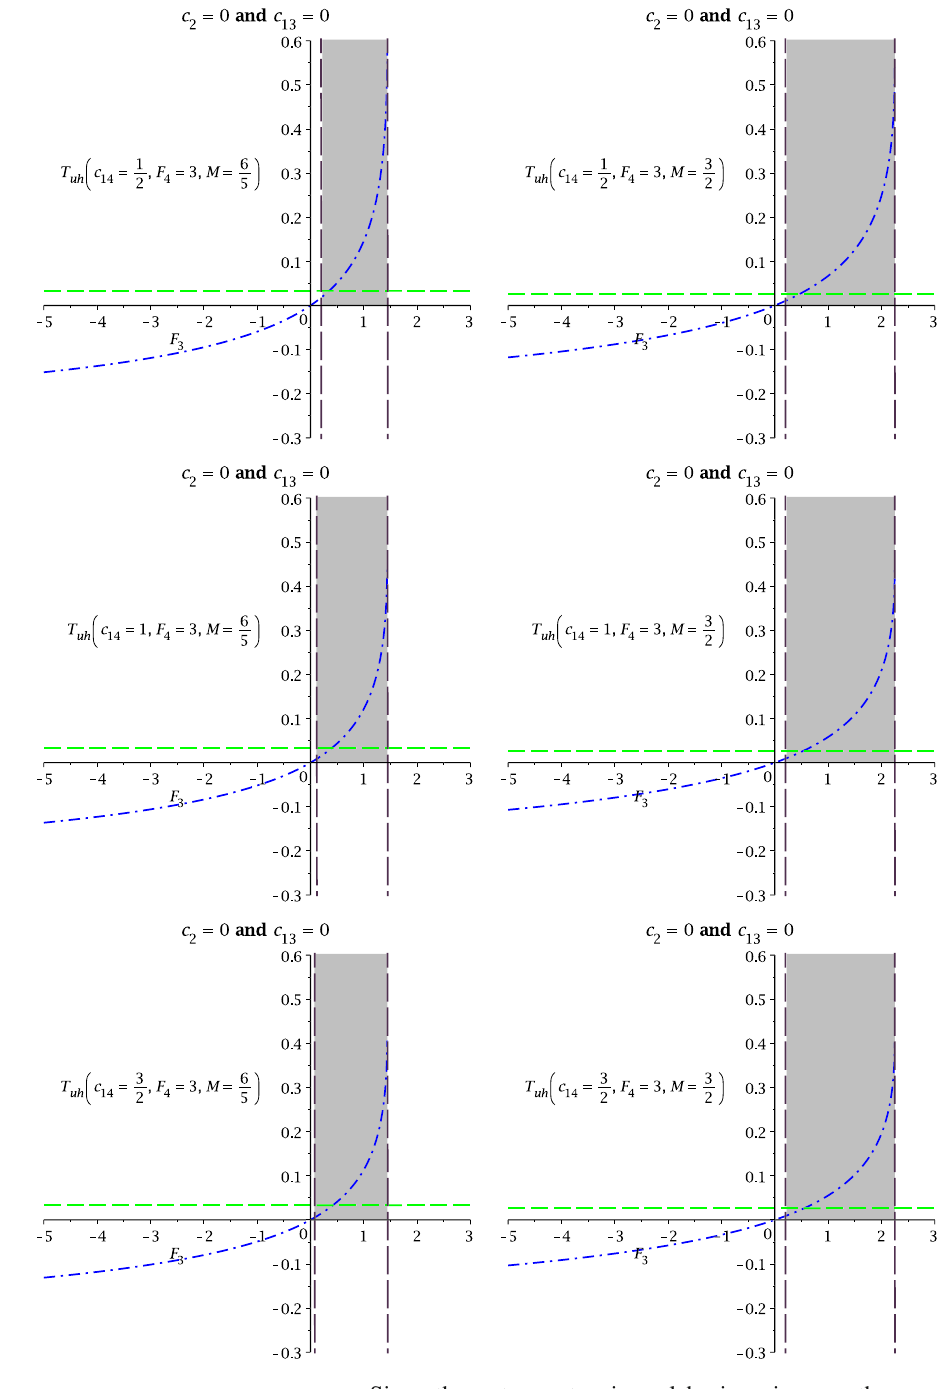
Fig. 5 These figures show the universal horizon temperatures, for the Case D, where we have: T uh 1 (blue dot-dashed line) and T GR (green dashed line). The violet long-dashed straight lines represent the inferior and superior limits of F 3 . The gray areas are the regions where the condition (99) is